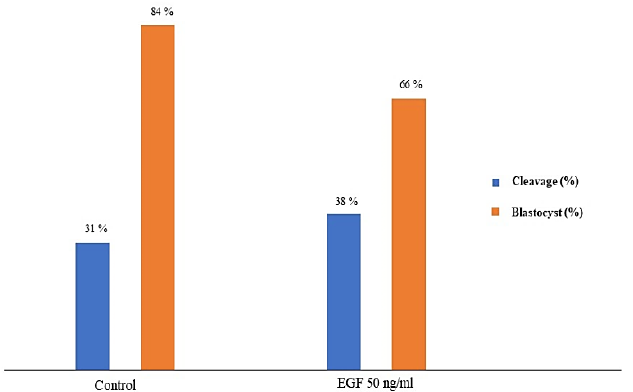
Figure 1. Differences in cleavage and blastocyst formation (%) between in vitro-produced embryos fertilized with thawed semen fertilized in the presence or the absence (controls) of epidermal growth factor (EGF 50 ng/mL). p > 0.05.